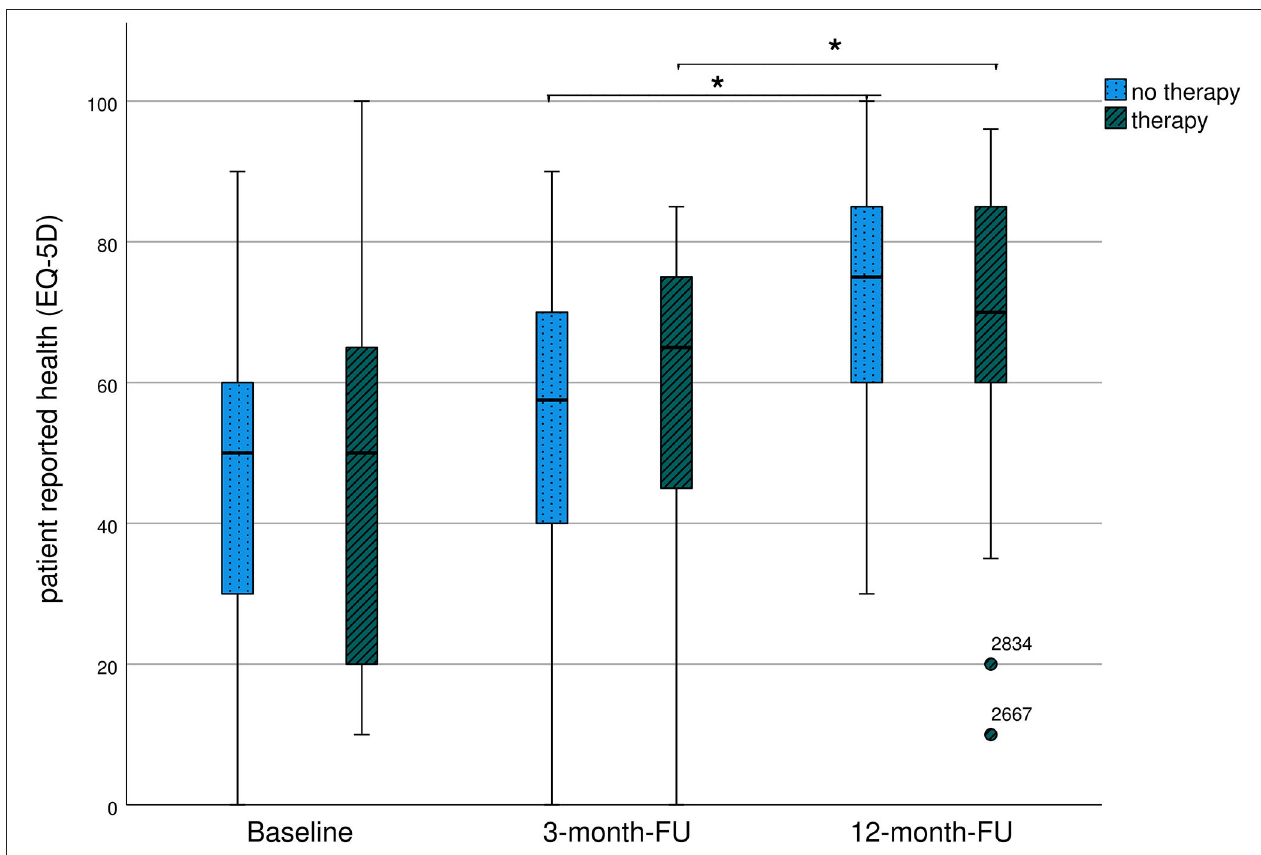
FIGURE 3 | Long-term course of patient-reported health (EQ VAS) of severely affected patients (mRS 3-5)-representation as boxplots. *Significant differences between